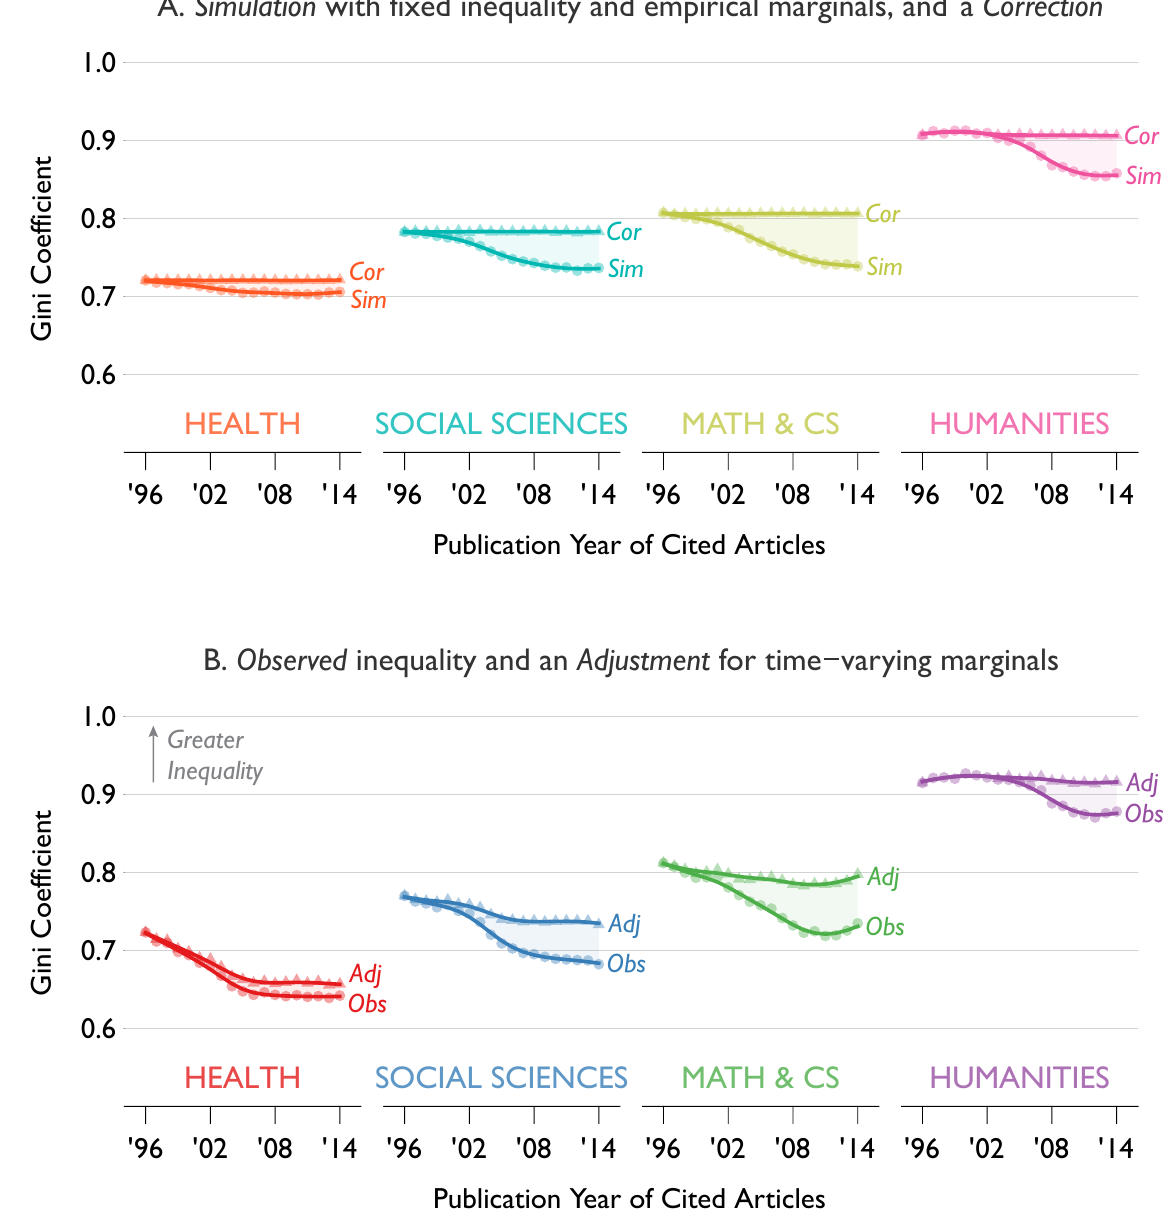
Figure 3: Gini coefficient for citations within two years of publication, 1996–2014: Monte Carlo simulation and empirical results. Notes : The lines in the top panel marked Sim show Gini coefficients of citation distributions from Monte Carlo results for hypothetical articles and citations designed to have a fixed pattern of inequality across years and fields, but total articles and citations matching the empirical marginals of those fields by year. The lines marked Cor remove the marginals bias in the Gini coefficient using a resampling correction. The lines marked Obs in the bottom panel shows Gini coefficients over fields and time using the empirical data from Web of Science; these results are subject to marginals bias from differences in total articles and citations by field and year. Lines marked Adj adjust for marginals bias in the empirical data by resampling to the marginals in 1996 by field. Corrections and adjustments are omitted for the humanities in 1997–2002. All curves are smoothing splines with a span of 0.5. One exceptionally highly cited article in mathematics and computer science is